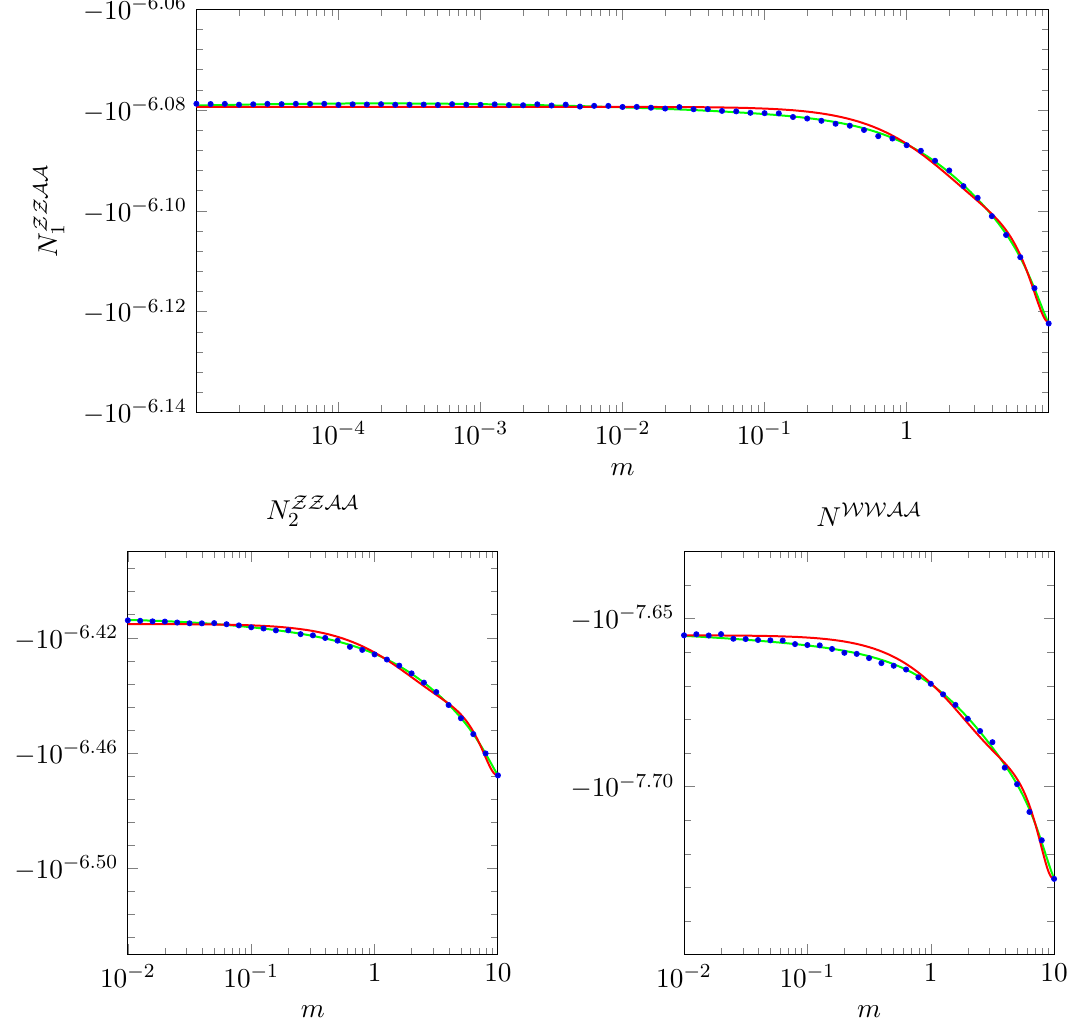
Figure 4 . Top: N ZZAA , Bottom Left: N ZZAA , Bottom Right: N WWAA , as functions of the 1 2 fermions’ mass m . The green line includes the IR divergent log( m=M H ) and log( m=M H ) 2 depen- dence of eq. (5.50) while the red line neglects these contributions. The top plot shows a larger